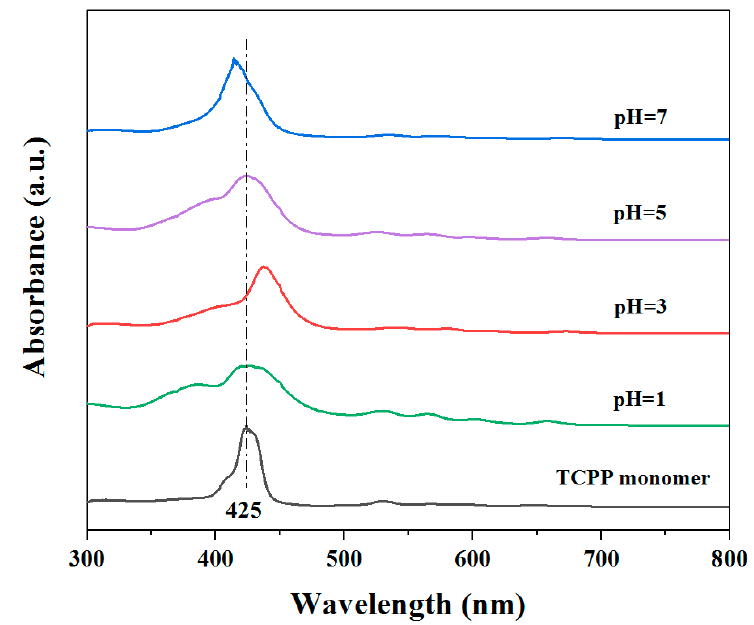
Figure 9. UV − vis absorption spectra of TCPP solution in N,N-Dimethylformamide (DMF) and CTAB-TCPP with different pH.